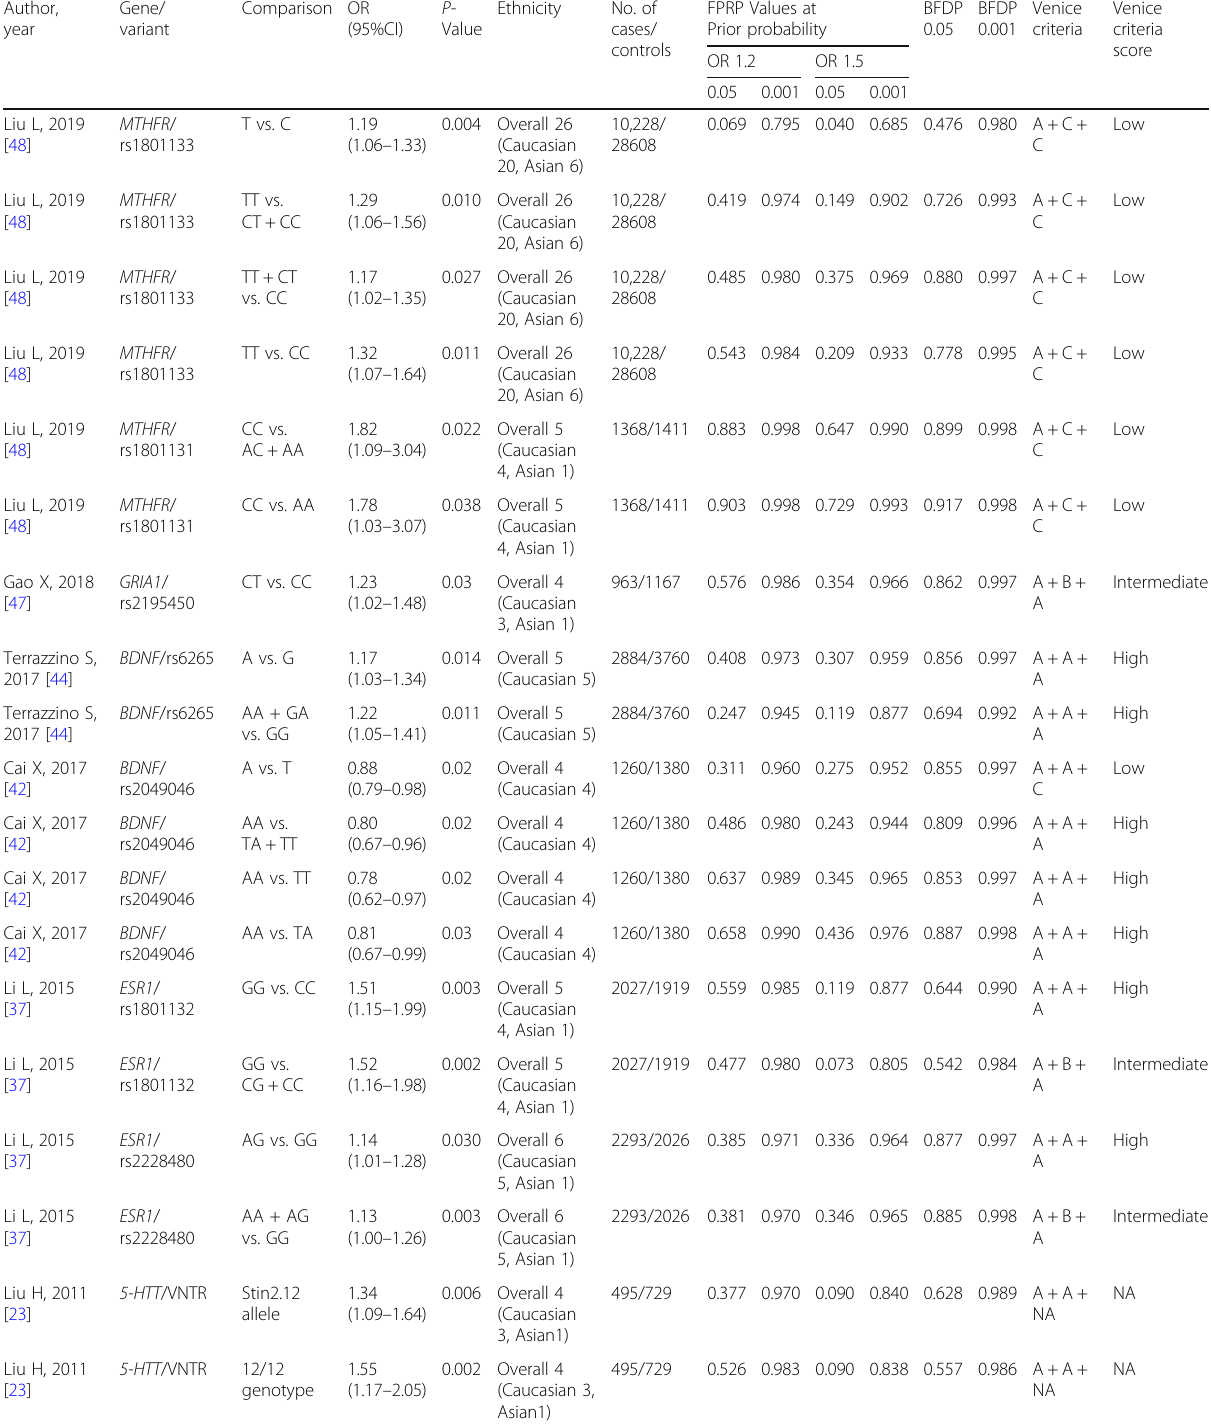
Table 1 Meta-analyses results of genetic variants with statistically significance ( P -value< 0.05) from observational